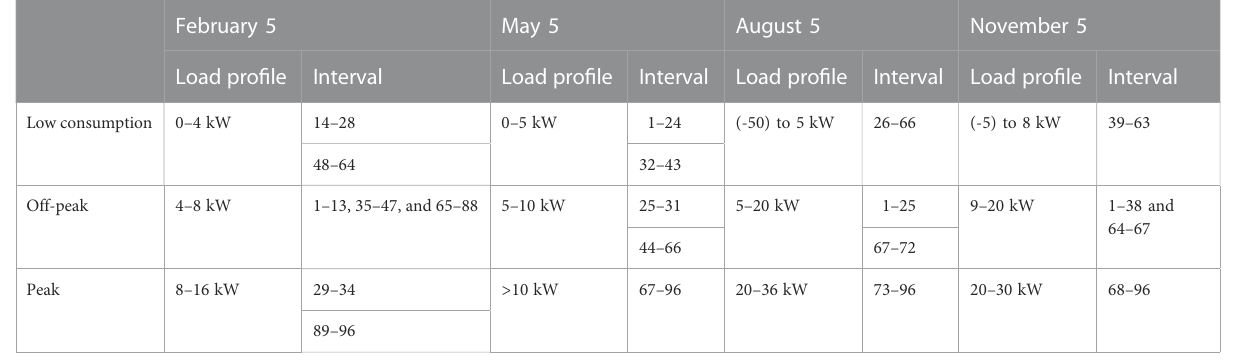
TABLE 1 Categorization of the load pro fi